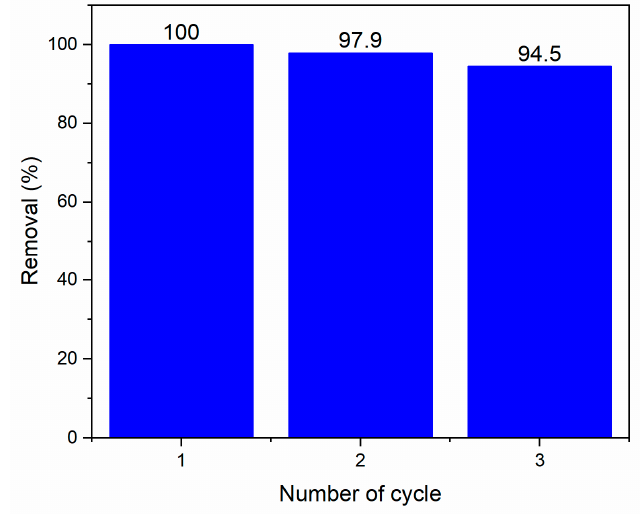
Figure 11. Recycling and reuse of ZnO- Tagetes erecta nanoparticles .